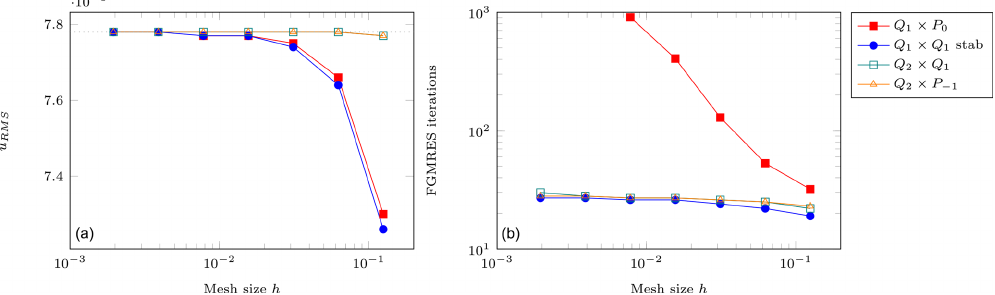
Figure 3. Donea and Huerta benchmark. (a) Root mean square velocity as a function of the mesh size h . The dotted line is the analytical value. (b) Number of FGMRES solver iterations as a function of the mesh size h .